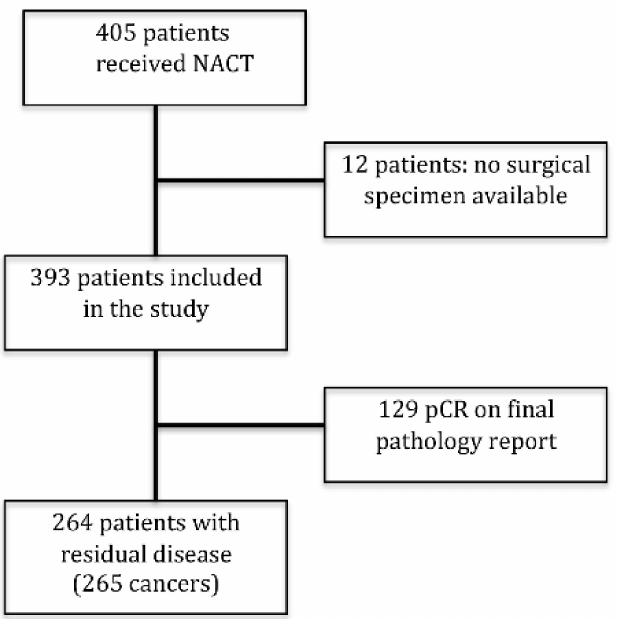
Figure 1. Case selection: among 405 consecutive patients undergoing NACT for breast cancer (January 2011–December 2018), 141 patients were excluded: 12 patients without surgical specimen (metastatic progression, surgery refusal, migration to another hospital), and 129 patients who had a pathological complete response (pCR). Therefore, 265 breast cancers from 264 patients (one patient had a bilateral tumor at presentation) were examined in the present